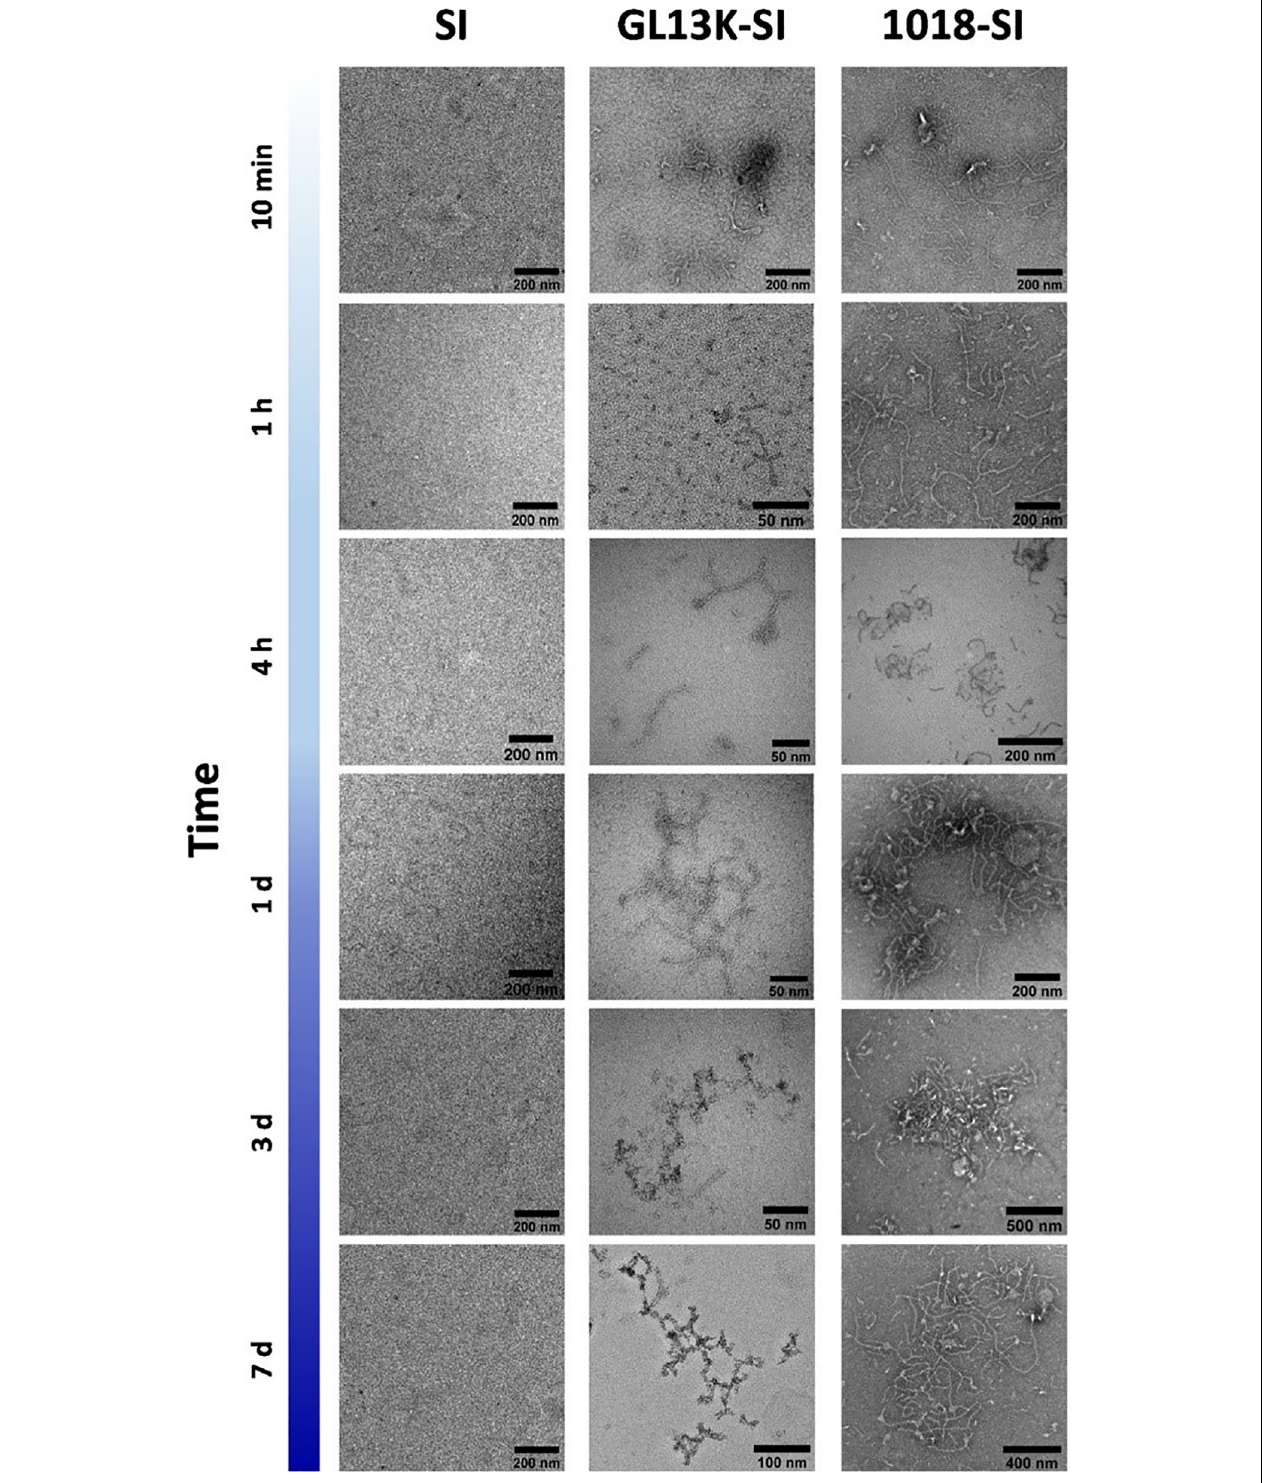
FIGURE 7 | Representative TEM micrographs of small nanofibers formed by hybrid AMP-ELRs (GL13K-SI and 1018 SI), compared with control ELR (SI), after incubation at 5 ◦ C. Reproduced with permission from (doi:10.1021/acs.biomac.0c00865), copyright 2020.